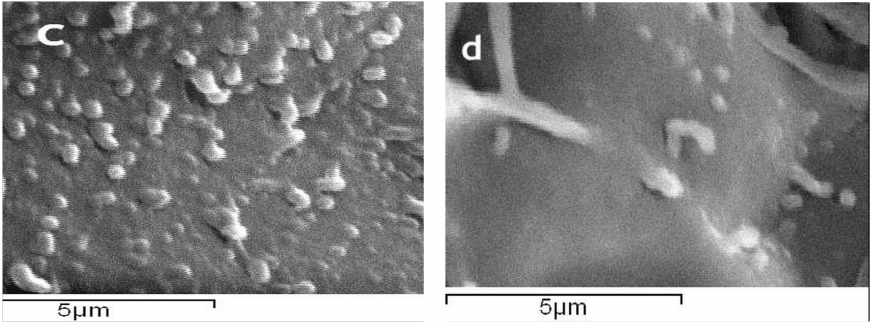
Figure 2. SEM images of SF nanoparticles ( a ); SF-propanolol NPs ( b ); SF-pramipexole NPs ( c ); and SF-curcumin NPs ( d ).